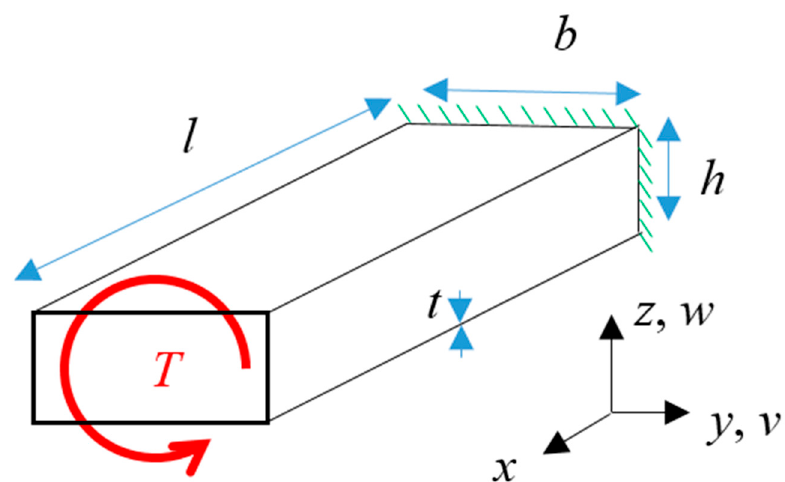
Figure 2. A cantilevered rectangular pipe under torsion.